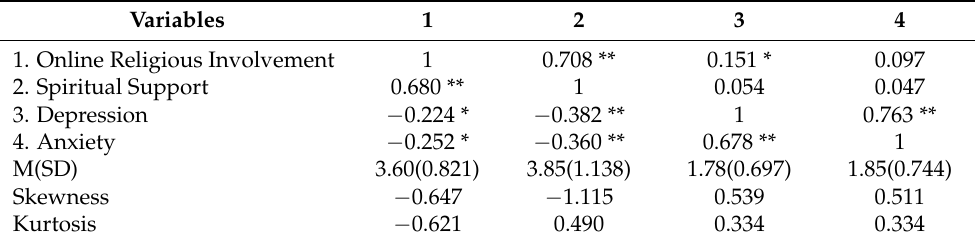
Table 1. Correlations, Mean Values, Standard Deviations, Skewness, and Kurtosis of Variables.